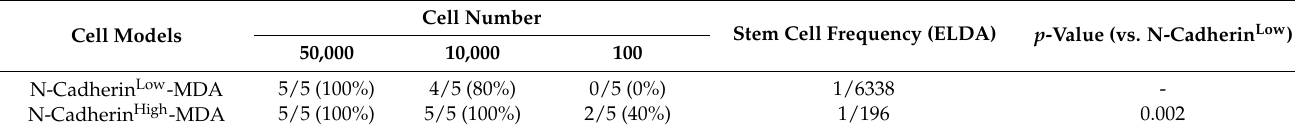
Table 1. Stem cell frequency in N-Cadherin High and N-Cadherin Low MDA